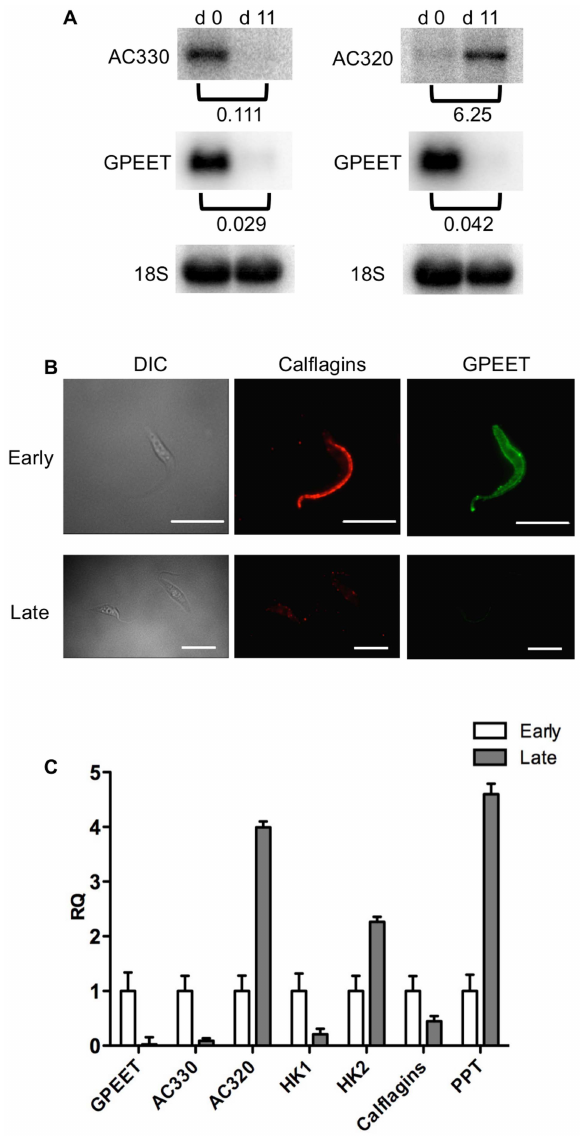
Figure 6. Differential expression of markers in early and late procyclic culture forms. (A) Northern blot analysis of adenylate cyclases Tb927.5.330 (AC 330) and Tb.927.5.320/285b (AC 320). GPEET was used to verify that the cultures correspond to early and late procyclic forms, respectively. Signals were quantified using a Phos- phoImager and normalised against 18S rRNA as described previously [47]. Signals in early procyclic forms were set at 1. (B) Immunofluores- cence analysis reveals that GPEET and calflagin are co-expressed by early procyclic culture forms and are not detectable in late procyclic culture forms. Scale bar: 10 m m. (C) Quantitative RT-PCR performed using RNA from early procyclic culture forms and late procyclic culture forms 11 days after removal of glycerol from the medium [4,7]. RQ: Relative quantification. Expression levels in early procyclic forms are set at 1. a -tubulin was used to normalise mRNA levels. Error bars are D Ct standard errors. AC 330: Tb927.5.330 3 9 UTR; AC 320: Tb927.5.320/285b 3 9 UTR; HK1: 3 9 UTR of Tb927.10.2010: HK2: 3 9 UTR of Tb927.10.2020; Calflagin: coding region of Tb927.8.5460, Tb927.8.5440, Tb927.8.5465, Tb927.8.5470. PPT: coding region of Tb927.1.2850, Tb927.1.2880 (putative pteridine transporters).